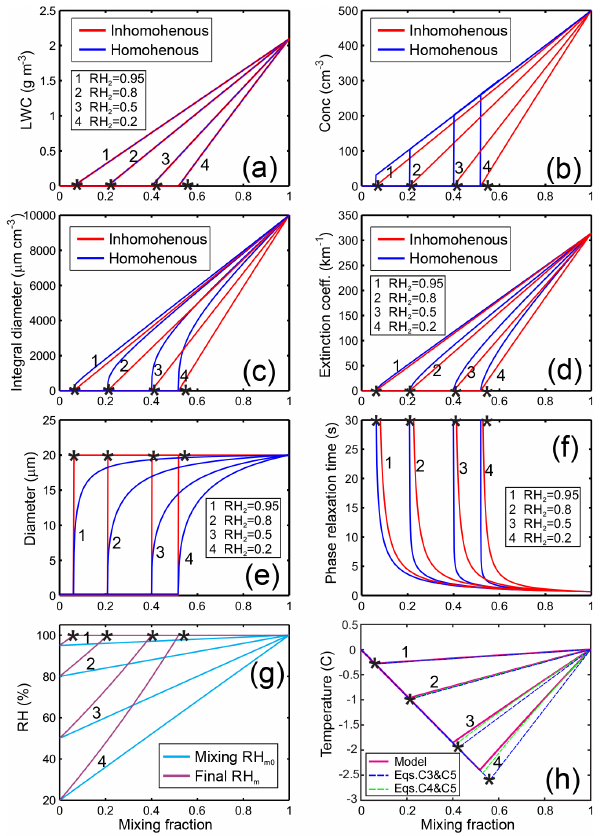
Figure 4. Simulation of (a) liquid water mixing ratio, (b) droplet number concentration, (c) integral droplet diameter, (d) extinction coefficient, (e) mean volume diameter, (f) time of phase relaxation, (g) relative humidity in the mixed volume before droplet evapora- tion RH m0 and at the equilibrium state RH m , (h) final tempera- ture T m0 vs. ratio of mixing µ formed after homogeneous and ex- treme inhomogeneous mixing between dry and cloudy parcel with monodisperse droplets. Black stars indicate critical mixing frac- tion µ cr calculated from Eq. (7). The calculations were performed for RH 2 = 0 . 2, 0.5, 0.8, 0.95; D 1 = 20µm, N 1 = 500cm − 3 ; T 1 = T 2 = 0 ◦ C; H =